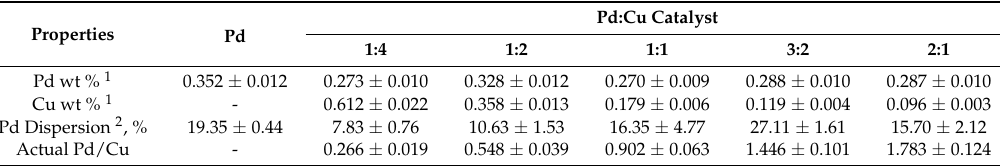
Table 1. Measured Pd and Cu contents and Pd dispersion of catalysts.